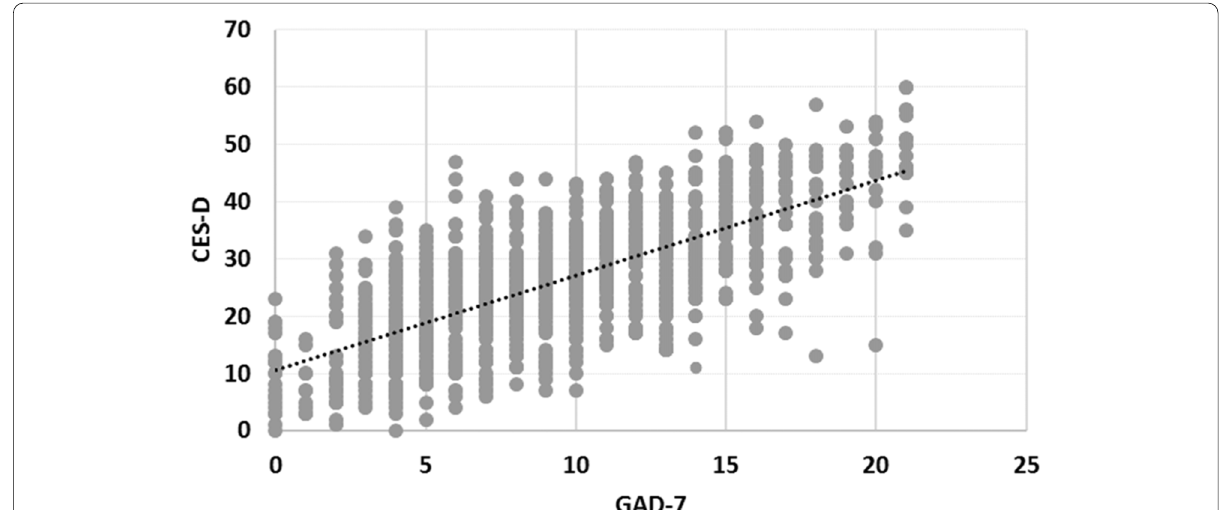
Fig. 1 The correlation between anxiety and depression (Pearson correlation